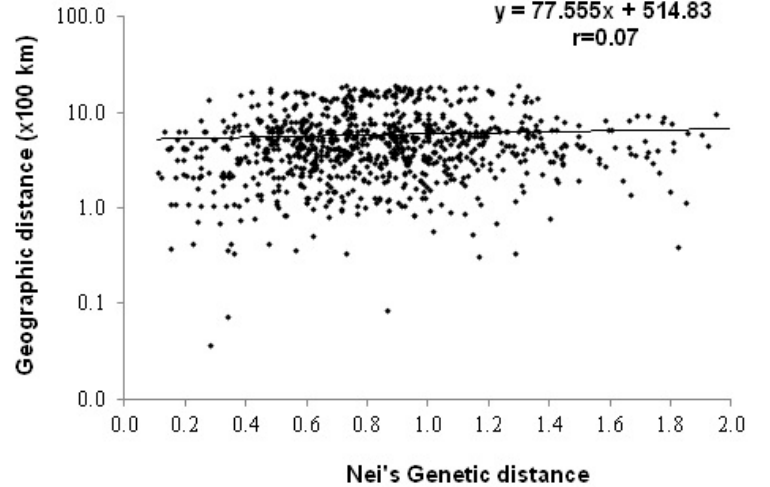
Figure 4. Mantel test revealing weak correlation between genetic and geographical distances in Acrocomia aculeata accessions collected from different geographical states in Brazil.